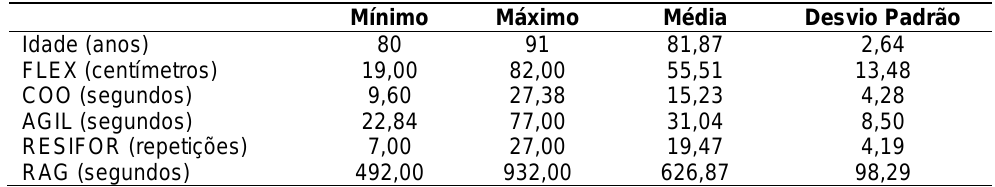
Tabela 1. Média, desvio padrão, valores mínimo e máximo dos testes motores de mulheres com idade a partir de 80 anos participantes dos programas de atividade